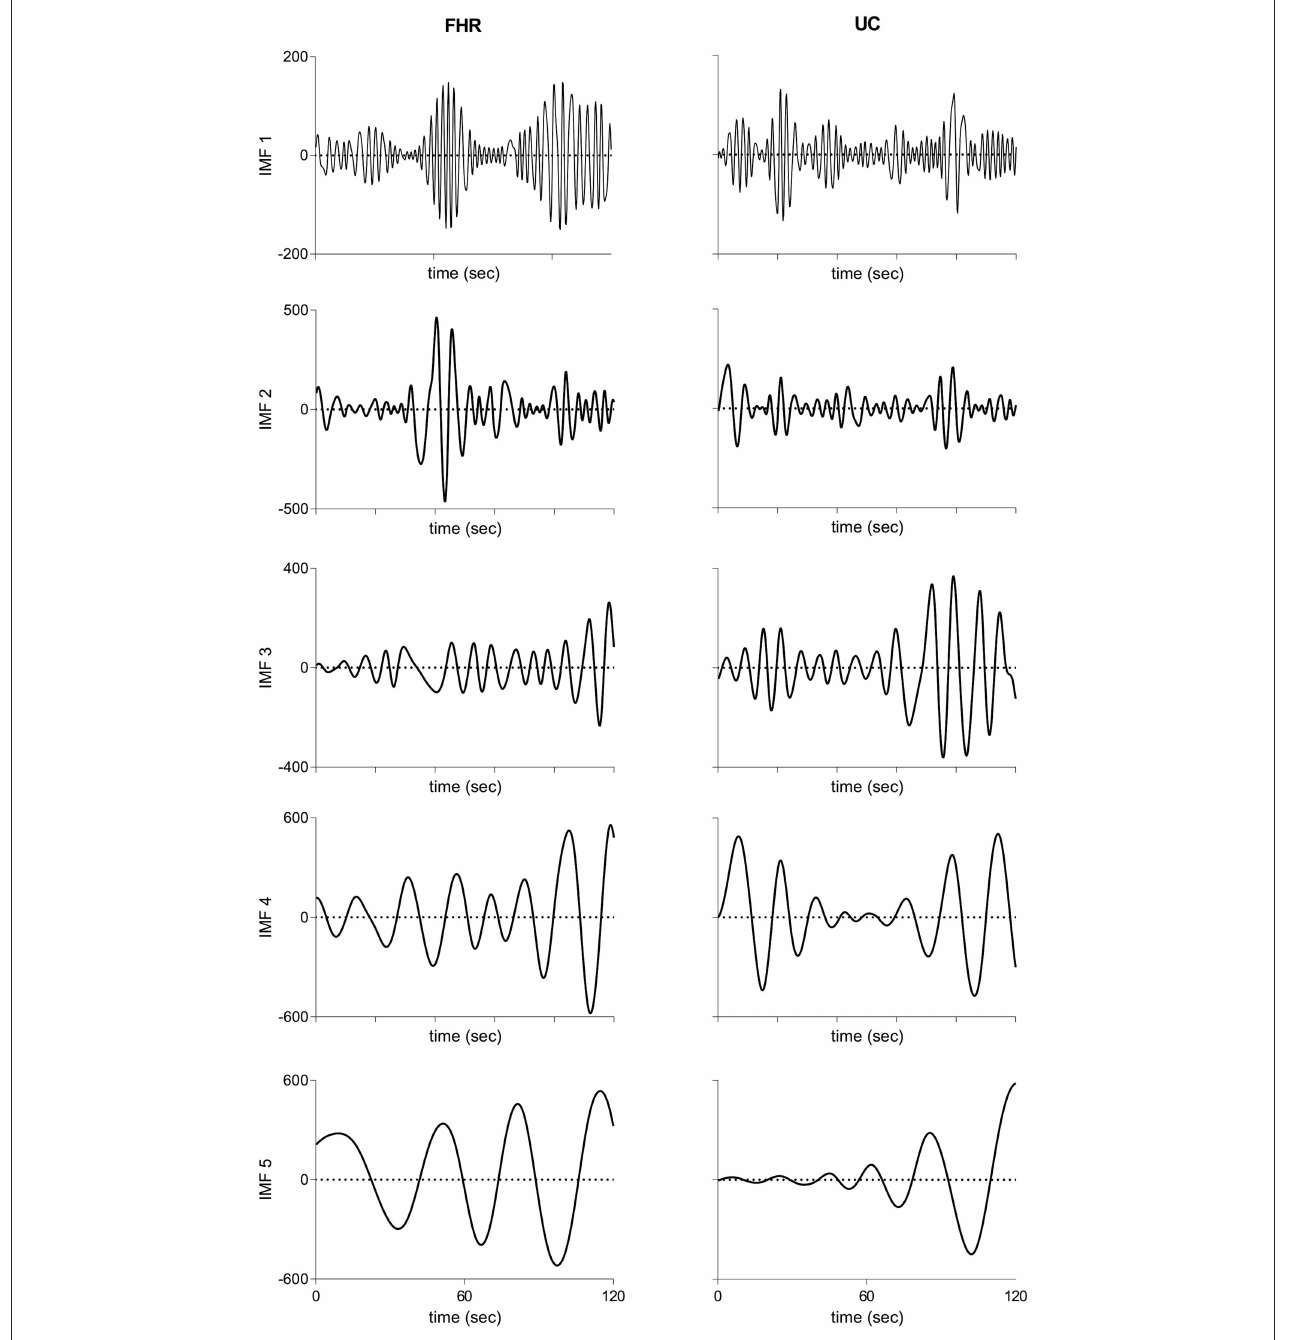
FIGURE 3 | Intrinsic mode functions derived from bivariate empirical mode decomposition of initial 2 mins recordings of FHR (Left panels) and UC (Right panels) recordings shown in Figure 2 . FHR, fetal heart rate; UC, uterine contraction; IMF, intrinsic mode function.